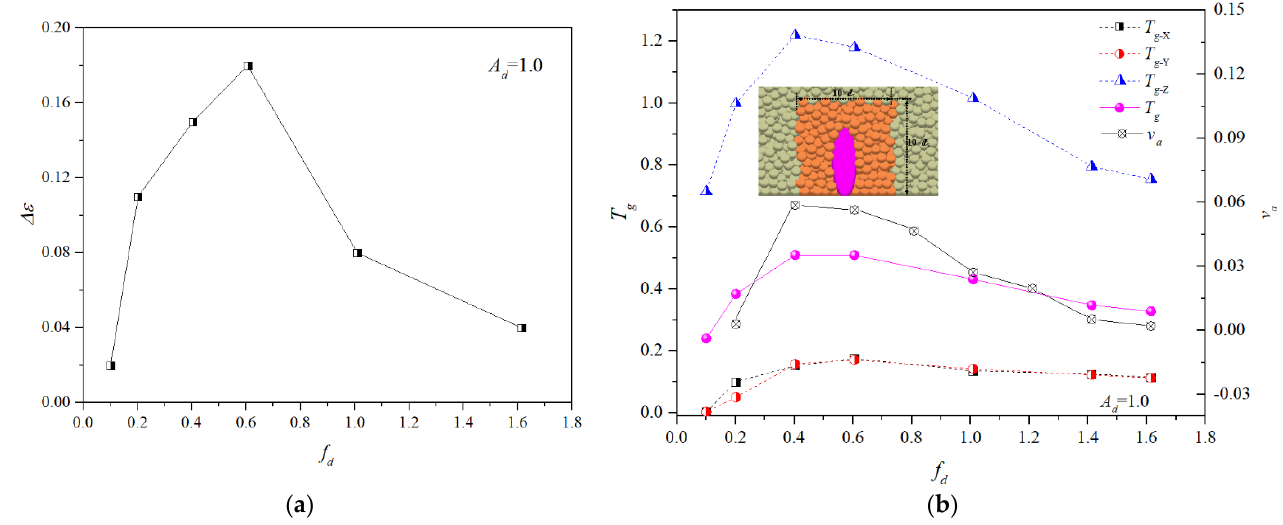
Processes 2021 , 9 , 448 Figure 8. The distribution of small particles at initial dyed layers and final layers after vibration of A =2 · d s .